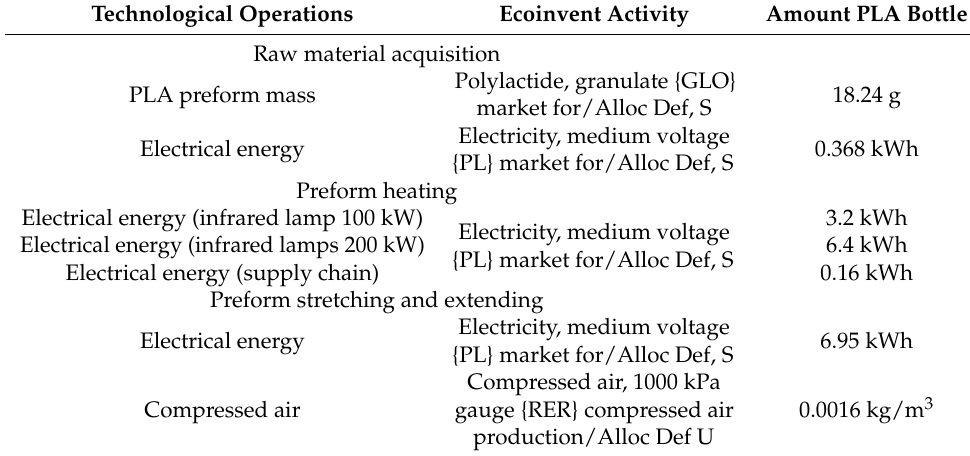
Table 1. The results of Life Cycle Inventory for the production of 1 bottle 1000 mL made with PLA